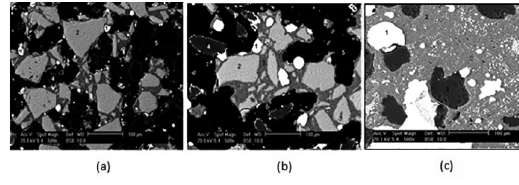
Figure 8: Self-reducing chromite pellet bound with 4% sodium silicate partially reduced at 1773 K for: a) 1; b) 2 and c) 10 min. Reaction fraction of 0.6; 0.75 and 1, respectively. SEM backscattered. Table 6: Chemical composition (wt%) of the core of the P7 pellet analyzed by EDS in SEM after reduction for 1, 2 and 10 minutes at 1773 K